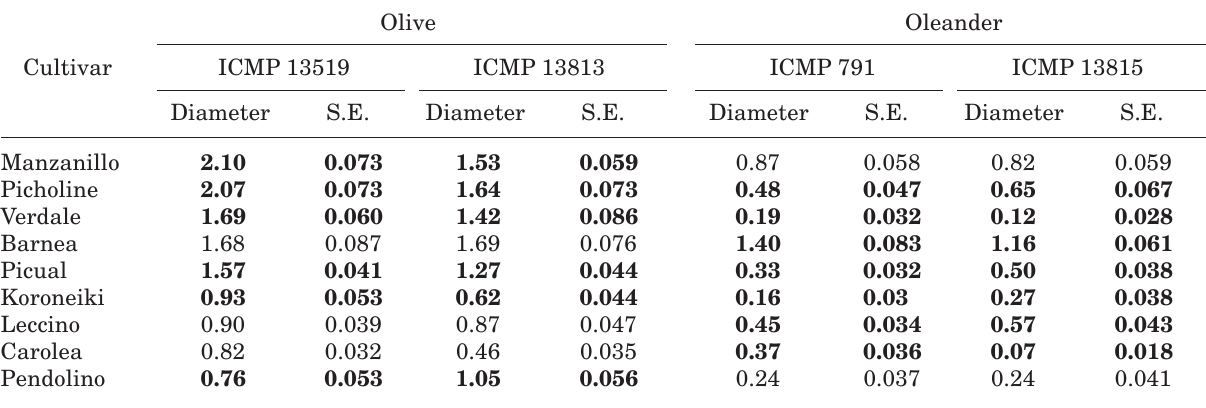
Table 1. Mean gall diameter (mm) in nine olive cultivars inoculated with P. savastanoi olive knot strains ICMP 13519 and 13813 and P. savastanoi oleander knot strains ICMP 791 and 13815 at concentrations of 3 (cid:1) 10 6 cfu ml -1 , recorded after 2 months. Mean diameters with their standard errors are indicated. Values in bold indicate signifi- cantly different reactions between strains in each